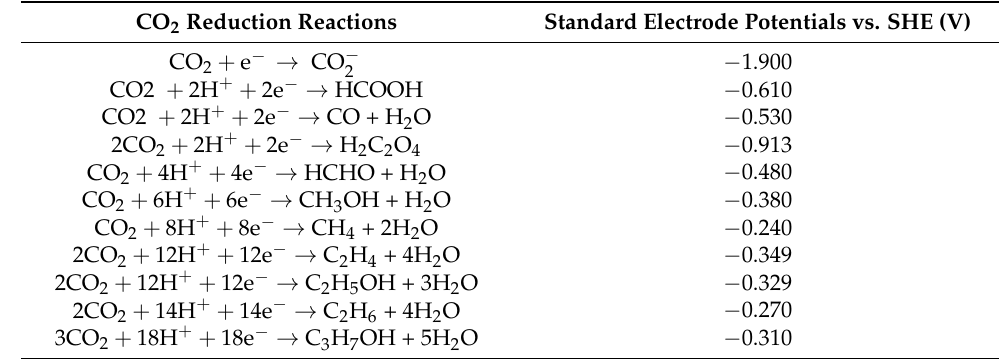
Table 1. Standard electrochemical potentials for reducing CO 2 into different